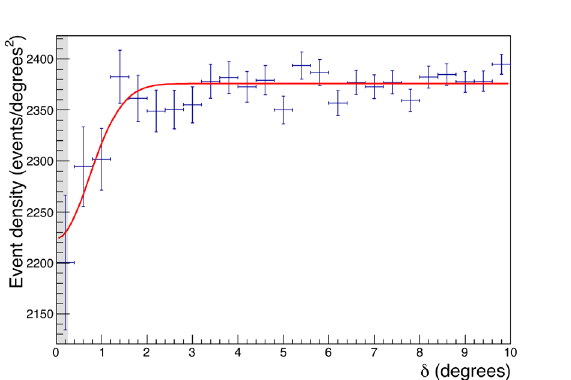
Figure 1. The distribution of the test statistic λ from eq. 1 for the “no Moon shadow” hypothesis H 0 (full curve) and the “Moon shadow” hypothesis H 1 (dotted curve). The dashed area corresponds to the 50% of the pseudo-experiments where the Moon shadow hypothesis H 1 is correctly identified. The tiny shaded area quantifies the expected median significance of 3.4 σ to observe the Moon shadow. Figure 2. Measured muon event density as a function of the angular distance δ from the Moon. The smooth line is the best fit according to equation (2); the shaded area corresponds to the apparent radius of the Moon (0.26 ◦